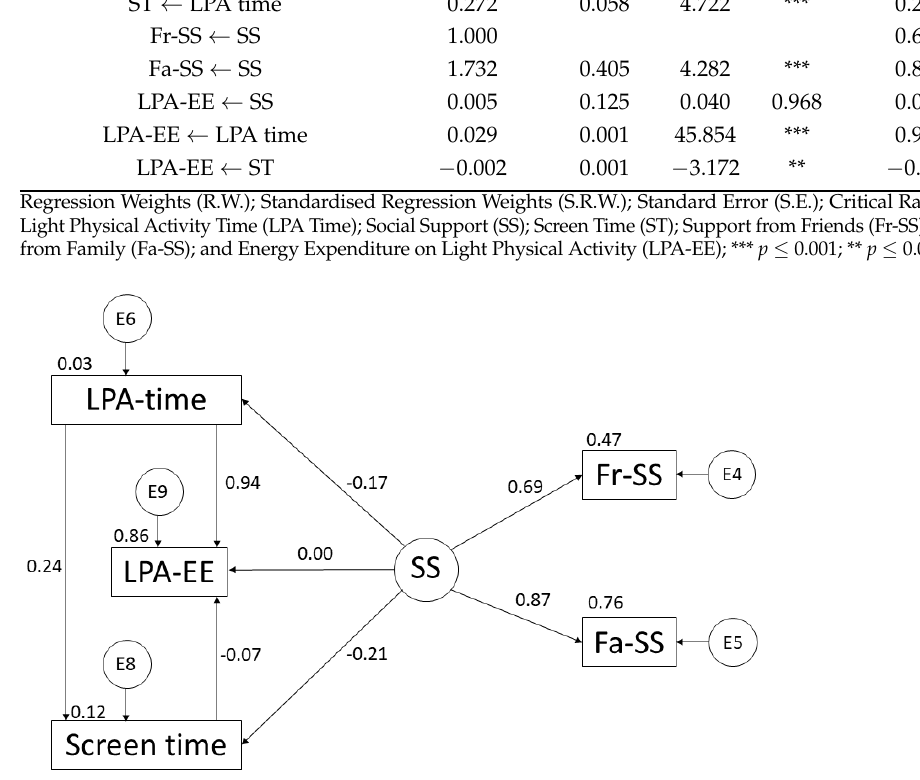
Table 1. The model developed for light physical activity. Associations between Variables